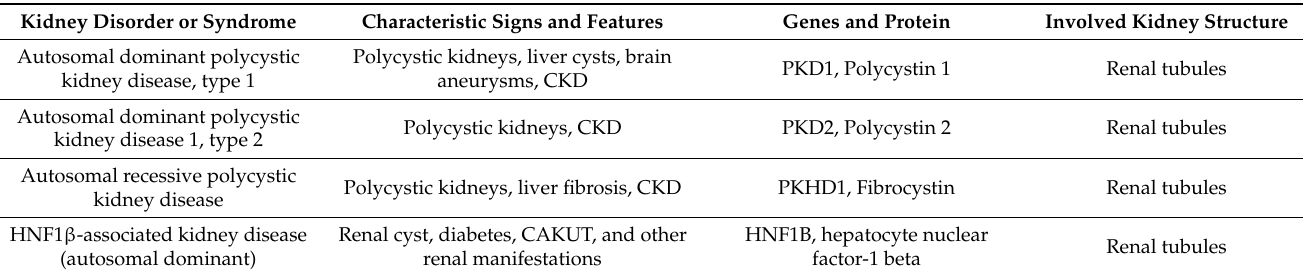
Table 1. Genes involved in major inherited kidney